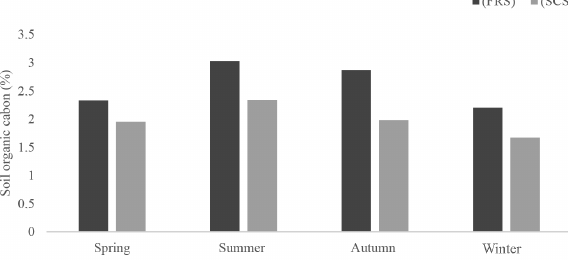
Figure 3. Seasonal variation in soil temperature at FRS and SCS